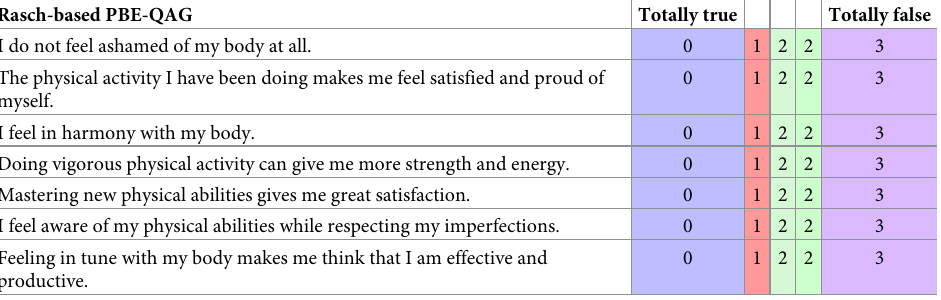
Table 2. Revised Rasch-based PBE-QAG for community-dwelling older adults.